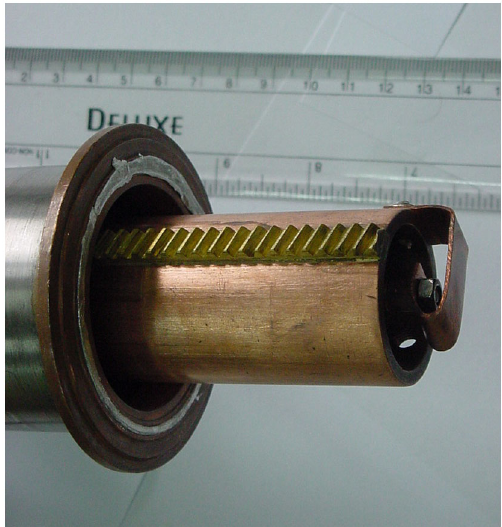
FIG. 10. (Color) The old power coupler.